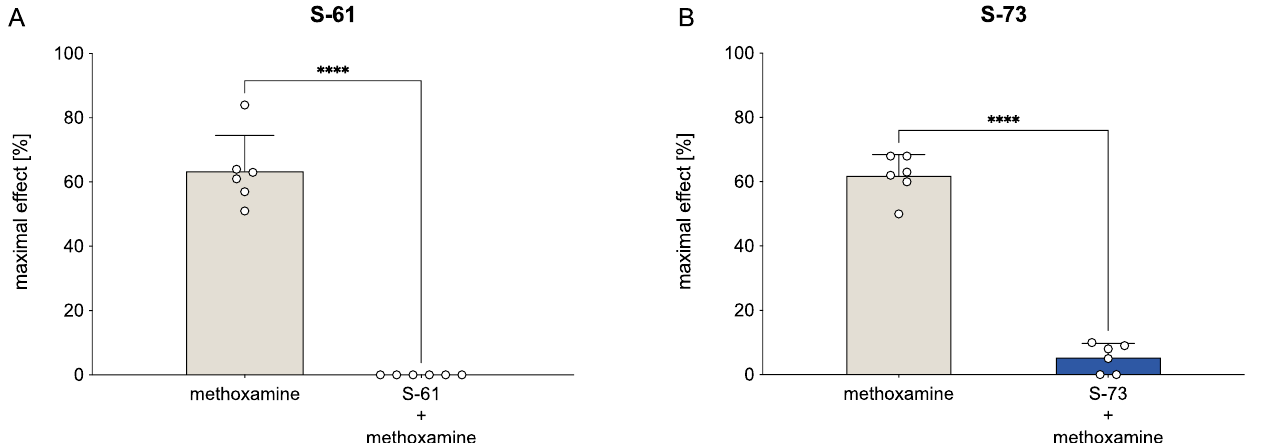
Figure 3. The effect of S-73 on the systolic (Panel A , C ) and diastolic blood pressure (Panel B , D ) in the normotensive rats. The blood pressure was measured before and 5, 10, 20, 30, 40, 50, and 60 min after the intravenous ( iv ) administration of either S-73 at the dose of 1 and 0.5 mg/kg or vehicle (saline). The results are presented as means ± SD. Statistical analysis: two-way repeated measures ANOVA (Bonferroni post hoc); * p < 0.05, *** p < 0.001, **** p < 0.0001; n = 6 rats. 2.6. S-61 and S-73 Abolished the Pressic Effect of Methoxamine S-61 administered at a dose of 1 mg/kg attenuated the methoxamine pressor response by 100% (t(5) = 13.87, p < 0.0001, Figure 4). The pressor effect of methoxamine was also abolished after the injection of the S-73 at a dose of 1 mg/kg by 91.4% (t(5) = 17.05, p < 0.0001).